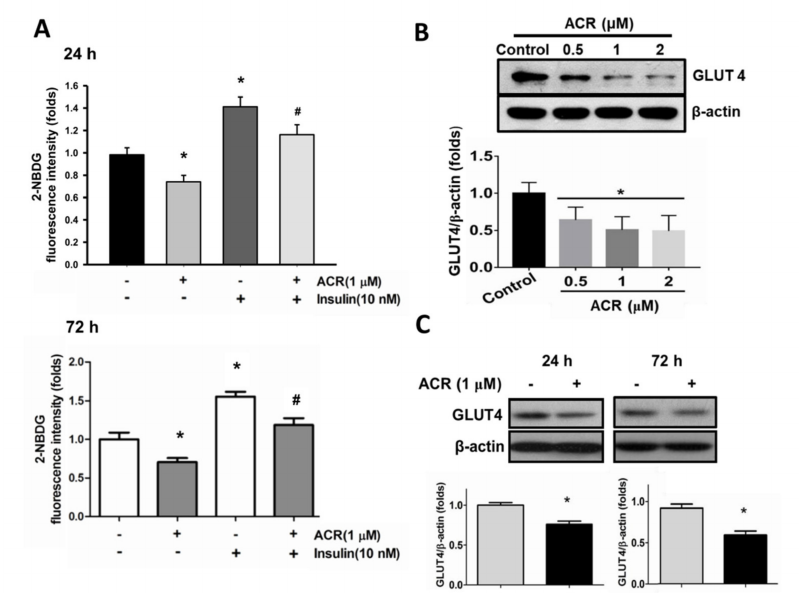
Figure 2. Effects of acrolein on glucose uptake and GLUT4 protein expression in differentiated C2C12 myotubes. ( A ) Myotubes were treated with 1 µ M acrolein in the presence or absence of insulin (10 nM) for 24 h and 72 h. The uptake of 2-NBDG into the myotubes was evaluated by a microplate fluorometer. ( B ) The GLUT4 protein expressions in myotubes treated with various concentrations of acrolein (0.5–2 µ M) for 24 h are shown. ( C ) The GLUT4 protein expressions in myotubes treated with acrolein (1 µ M) for 24 h and 72 h are shown. The protein expression was determined by Western blotting and quantified using densitometric analysis. Results are represented as means ± SEM for at least four independent experiments. * p < 0.05 versus vehicle control; # p < 0.05 versus acrolein alone.